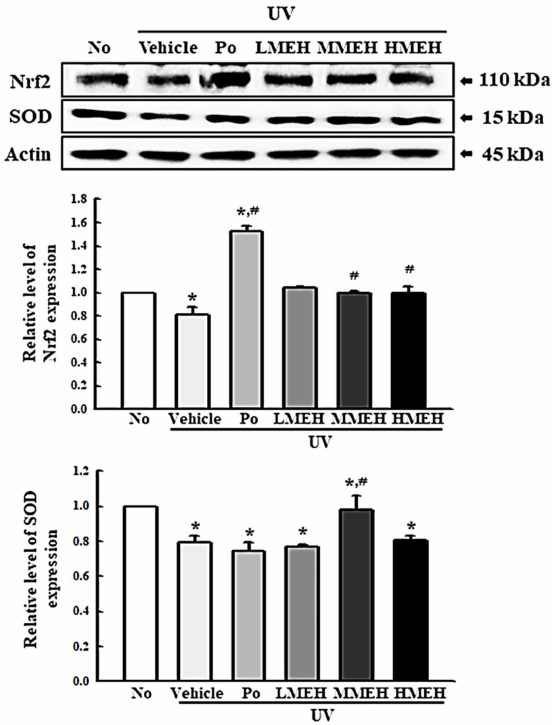
Figure 4. Detection of SOD and Nrf2 protein expression in normal human dermal fibroblasts. Expression level of the proteins was detected with the specific antibodies and quantified using an imaging densitometer. Determination of SOD activity. One SOD unit is defined as the amount of the enzyme in the sample (20 µ L) that inhibits the reduction reaction of water-soluble tetrazolium salt-1 (WST-1) with superoxide anion by 50%. Three dishes per group were used for Western blot assay, and the assay was repeated fir three times. Data are reported as the mean ± SD of triplicate determinations. *, p < 0.05 compared with the untreated group. #, p < 0.05 compared with the UV + Vehicle group. Abbreviations: SOD, superoxide dismutase; Nrf2, nuclear factor erythroid 2–related factor 2; Po, Positive control; MEH, Methanol extract of Hygrophila erecta (Brum. F.)